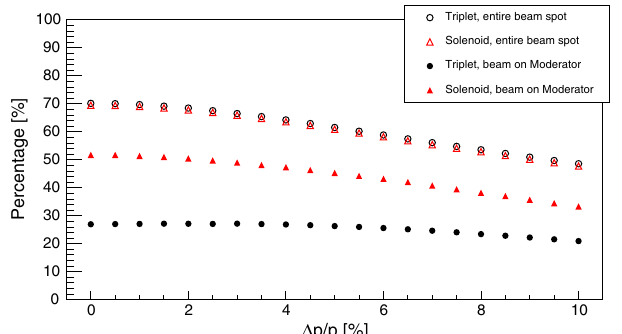
FIG. 7. The fractions of muons with the initial phase spaces used in TRANSPORT that are transported to the position of the moderator in G4beamline for the current μ E 4 beamline and the upgraded μ E 4 beamline. 100,000 muons for each momentum bite settings are generated in the simulation at the muon target E. Statistical errors of simulations are less than